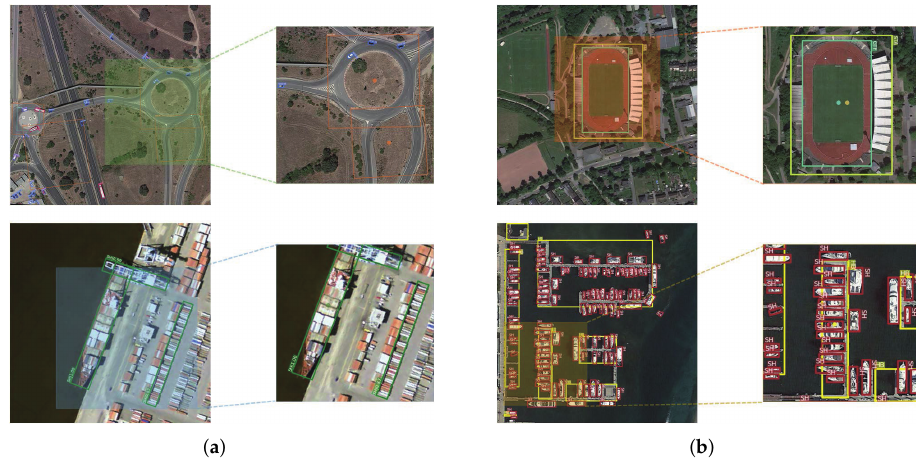
Figure 2. Appearance ambiguity problems of the keypoint-based anchor-free object detectors. ( a ) The central areas of the objects are similar to the backgrounds. ( b ) Some different categories objects share the same center